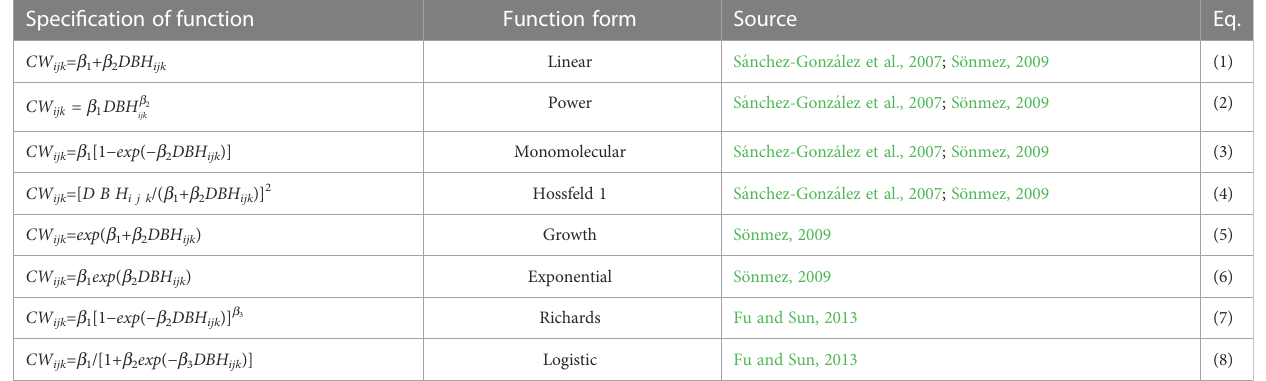
TABLE 3 Form of the base functions. CW ijk is the crown width of the k bamboo in the j sample plot in the i block, DBH is the diameter at breast height of the k bamboo in the j sample plot in the i block, b 1 − b 3 : model parameters. Speci fi cation of function Function form